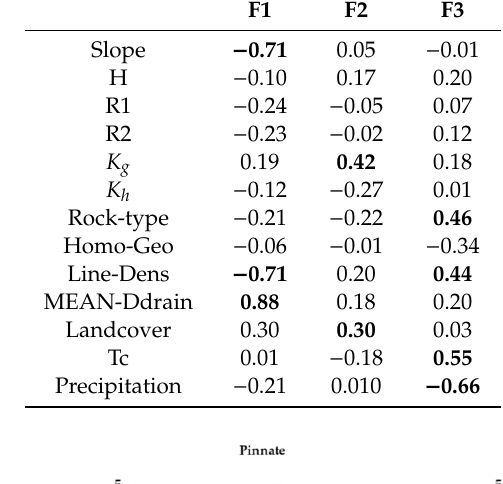
Table 5. Correlations between variables and discriminant functions of the total database (higher values are in bold).